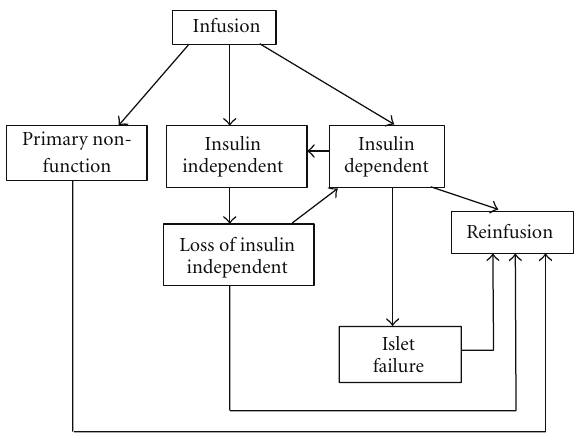
Figure 2: Possible states after first infusion.